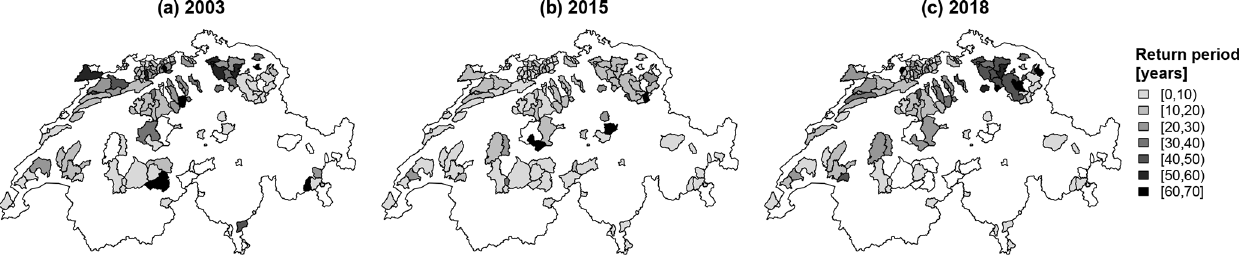
Figure 7. Bivariate AND return periods estimated for the drought events in (a) 2003, (b) 2015, and (c) 2018 for the 137 catchments in the observed dataset for the variable pair discharge deficit and discharge deficit duration. Darker shading indicates a longer return period. For catchments displayed in white, no joint events were